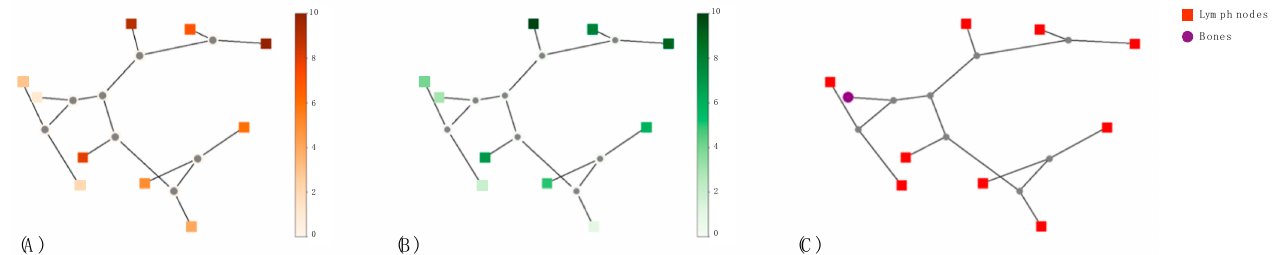
Figure 6. A patient tree-based representation. Lesions are colored according to biological characteri- zation, namely ( A ) their standard uptake values (SUV_max), ( B ) total lesion activity, TLA, and ( C ) tissue of their sites, such as proximal and distant lymph nodes (squares) or skeleton (circles). Of interest, close lesions and distant lesions presented different biological characteri- zation, as highlighted by the specific color encoding. Table 4 showed the discrimination